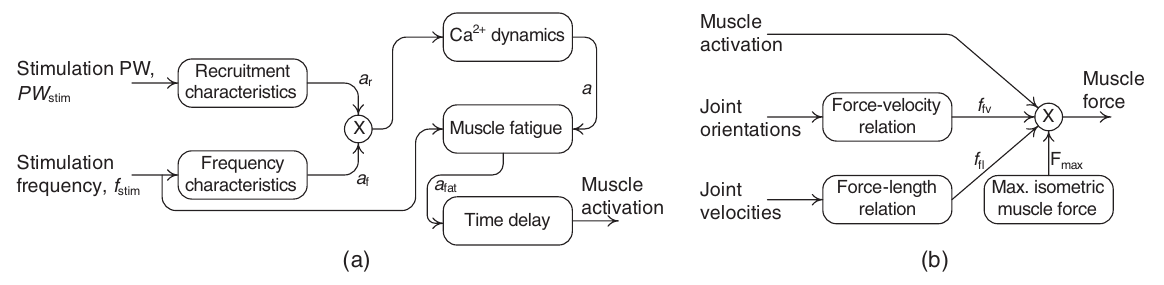
Fig. 1. Components of muscle dynamics (a) activation dynamics and (b) contraction dynamics